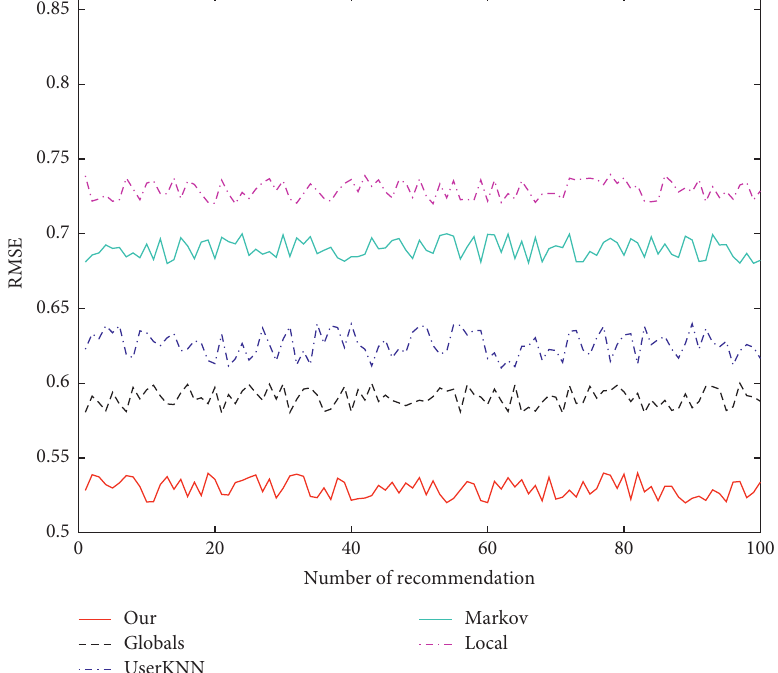
Figure 8: The comparison results compared with the PrefixSpan